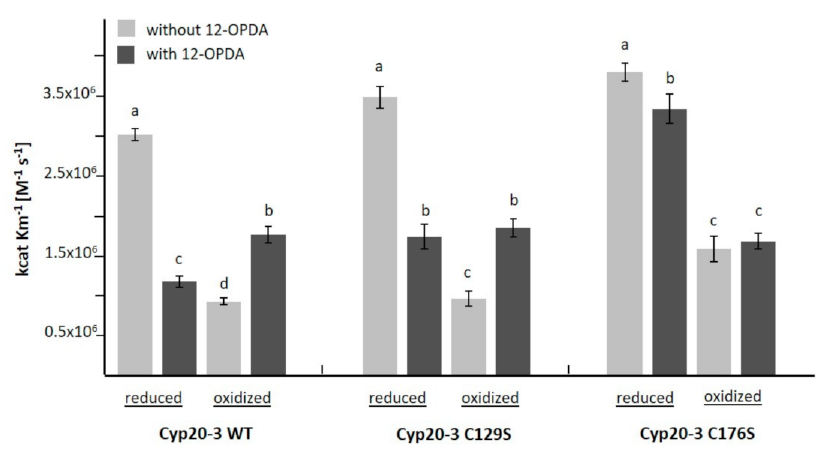
Figure 7. Activity of oxidized and reduced Cyp20-3 in the presence of 12-OPDA. Changed catalytic efficiency of PPI activity of Cyp20-3 validated the interaction with 12-OPDA. While reduced protein was inhibited by 12-OPDA, activity of oxidized protein increased. The activity of mutated C176S was only minimally affected by 12-OPDA. Data are means ± SD, n > 5. Significant differences at p ≤ 0.05 were calculated using one-way ANOVA with post hoc Tukey HSD and are represented by letters